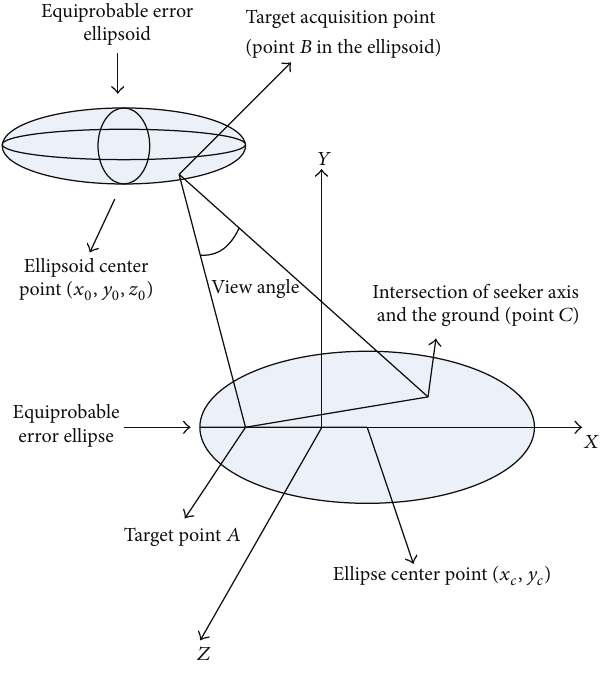
Figure 4: Equiprobable error ellipsoid and ellipse.